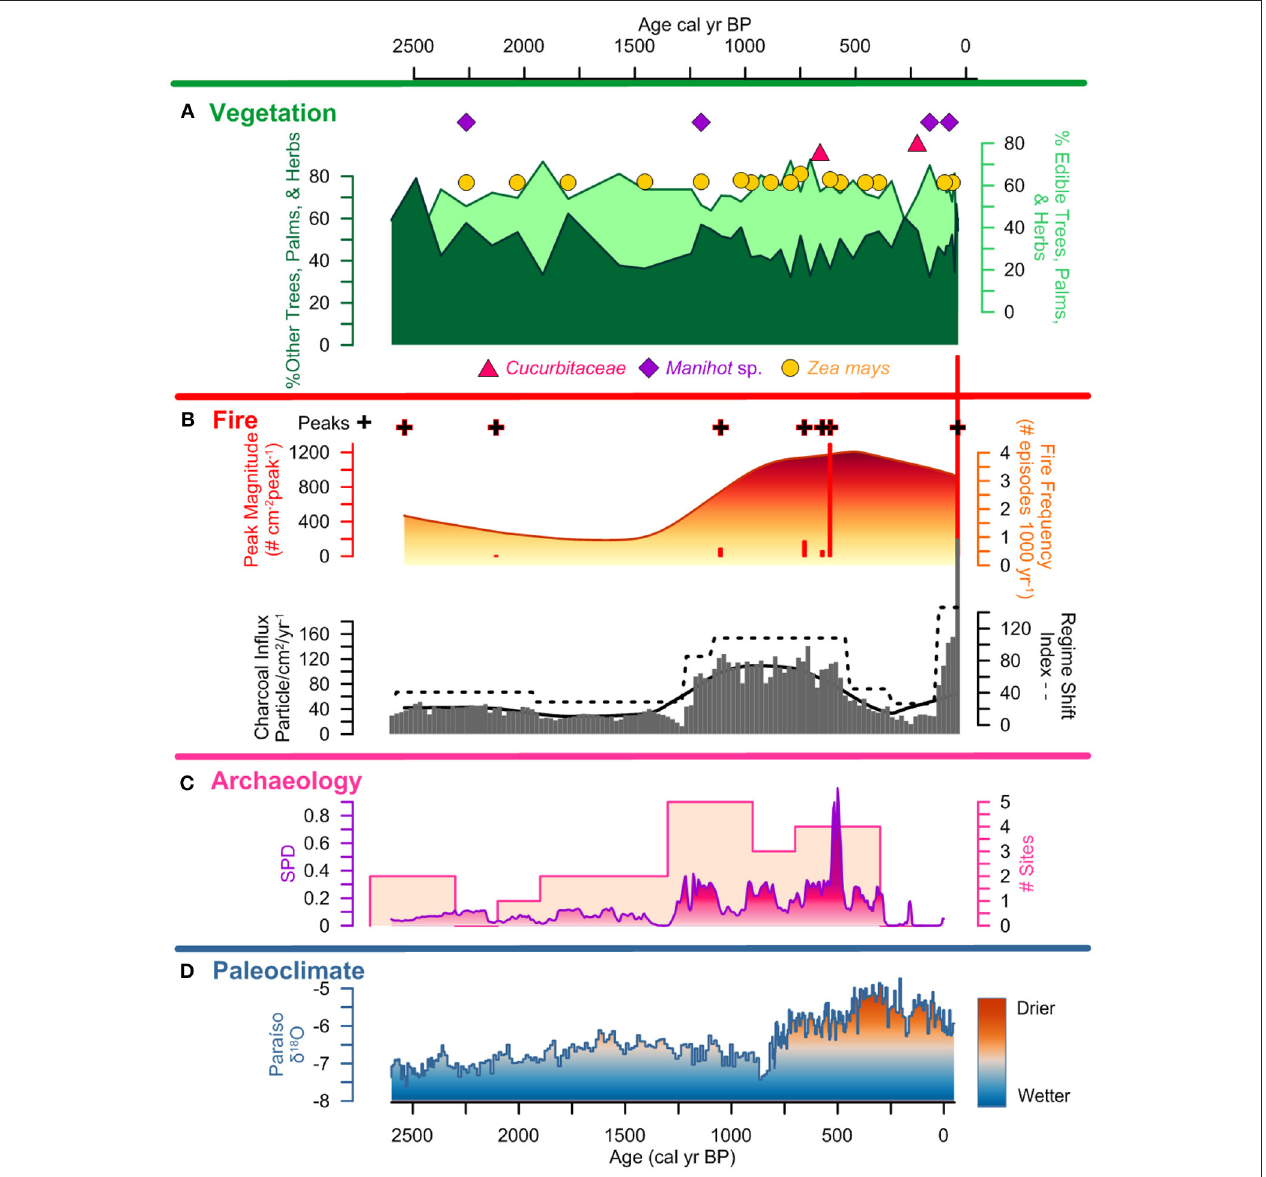
FIGURE 7 | Lago Caranã summary figure 2,500 cal yr BP to present: (A) vegetation: pollen summary data of edible and other trees, palms, and herbs, and crop pollen including maize ( Z. mays ), sweet potato ( Ipomea sp.), manioc ( Manihot sp.), and squash ( Cucurbita ), (B) fire: charcoal influx with black line indicating background, RSI, fire frequency, peaks, and peak magnitude from CHAR Analysis, and regional charcoal curve from sites compiled from the GCD, (C) archeology: summary data calculated from the sum of calibrated probability distributions (SPDs) and site frequency data (Maezumi et al., 2018), (D) paleoclimate: data from Paraíso Cave (Wang et al.,